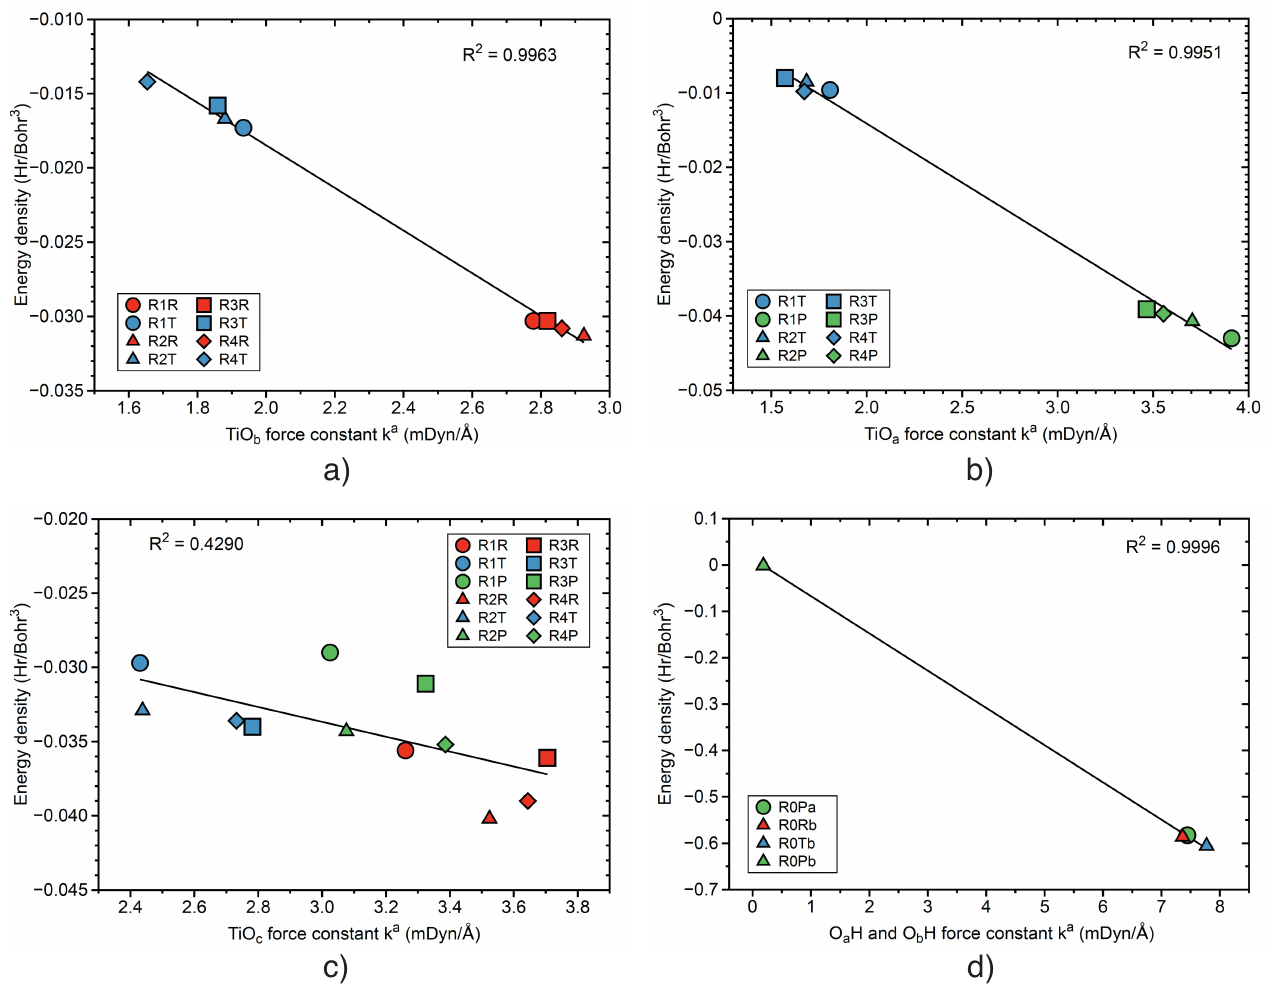
Figure 12. Correlation between energy density and local mode force constant. ( a – c ) TiO b , TiO a and TiO c bonds and ( d ) O a H and O b H bonds. RnR, RnT and RnP indicate the reactant (red color), TS (blue color) and product (green color) for reactions Rn , with n=0, · · · 4. B3LYP/6-31G(d,p)/SDD(Ti) level of